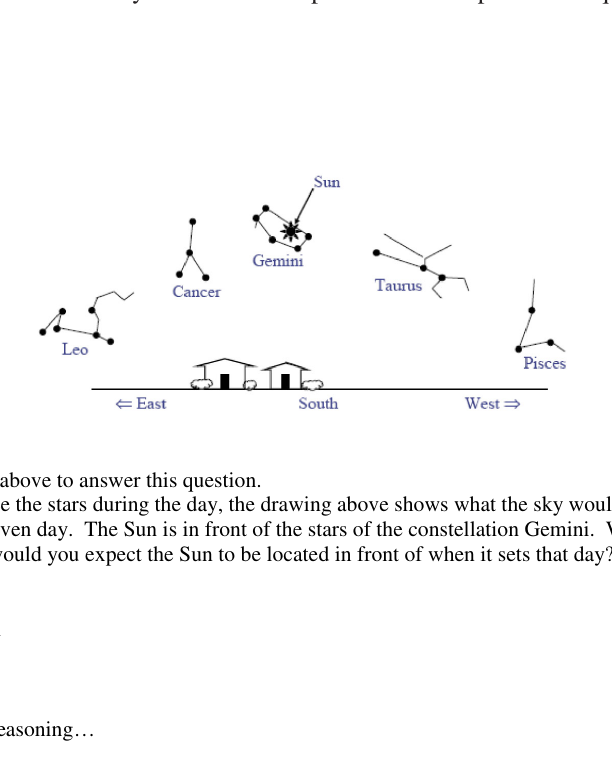
FIG. 13. Assessment used to measure students ’ ability to describe the Sun ’ s daily motion versus annual motion. The distributions of students choosing the correct multiple-choice response and attaining the minimum rubric score can be found in Fig. 6. This question was adapted from the Astronomy Diagnostic